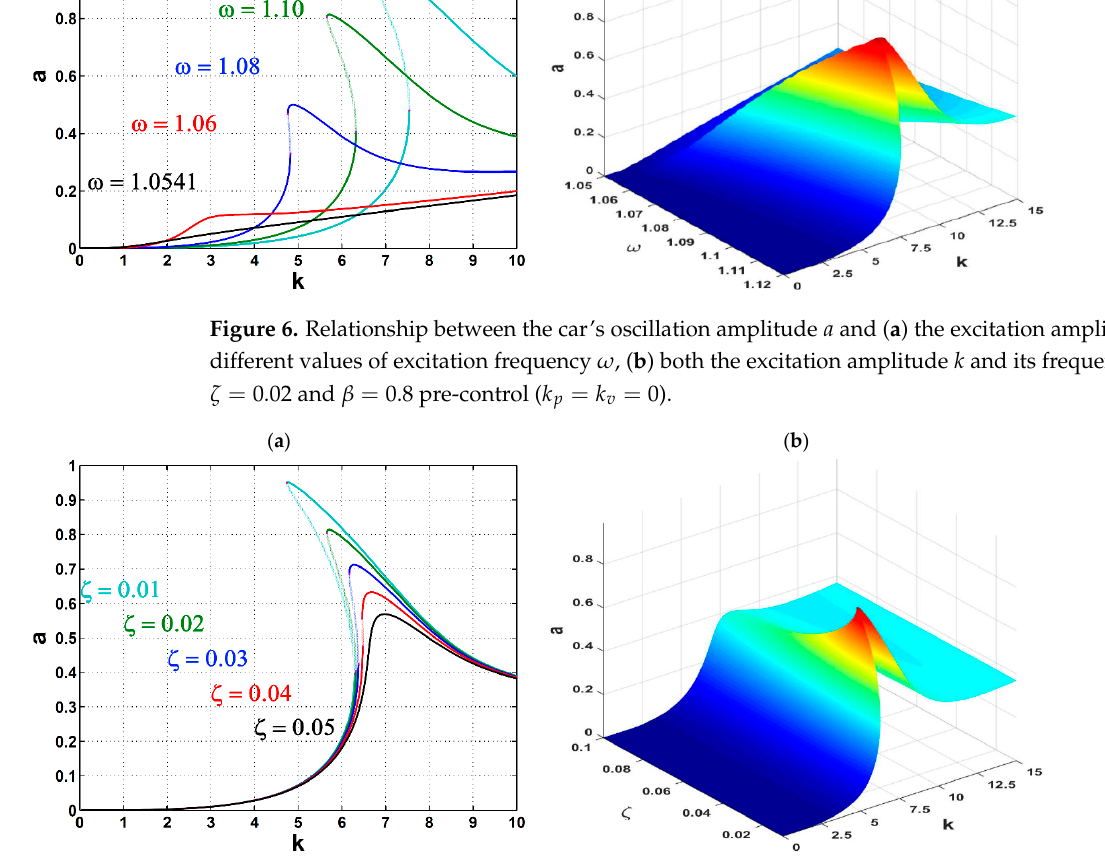
Figure 7. Relationship between the car’s oscillation amplitude (cid:1853) and ( a ) the excitation amplitude (cid:1863) at different values of damping factor (cid:2014) , ( b ) both the excitation amplitude (cid:1863) and damping factor (cid:2014) , at (cid:2033) = 1.1 and (cid:2010) = 0.8 pre-control ( (cid:1863) (cid:3043) = (cid:1863) (cid:3049) = 0 ).